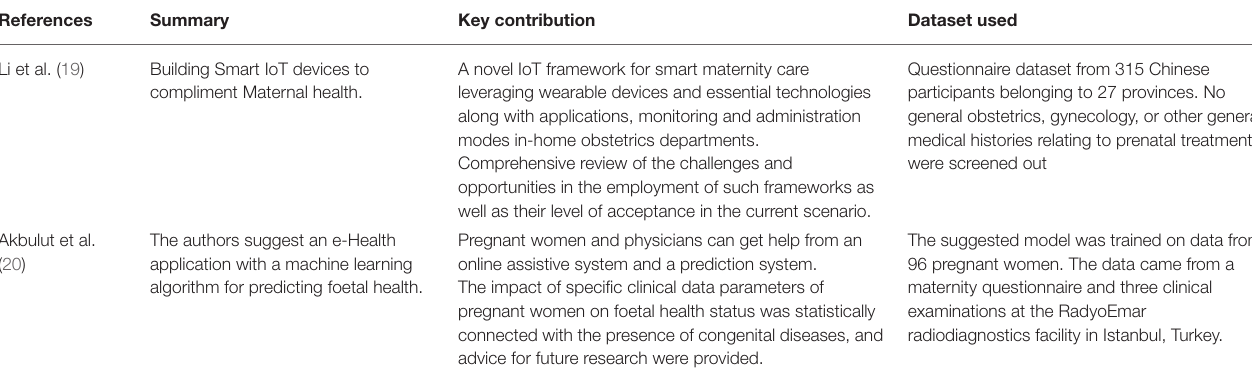
TABLE 2 | Smart devices and applications based maternal health